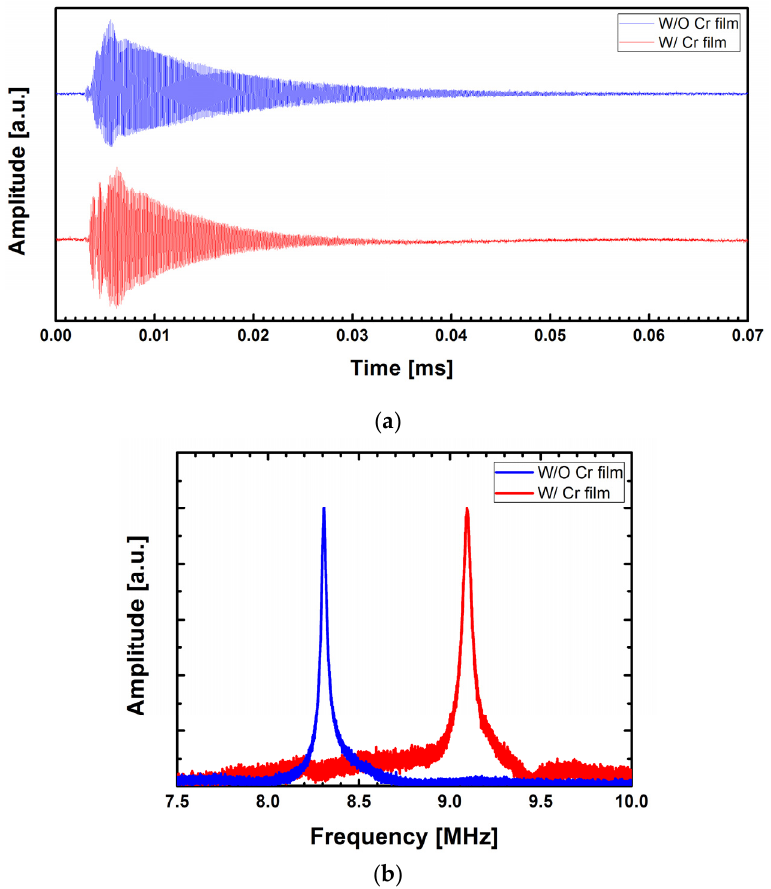
Figure 7. ( a ) Time-domain waveforms of the micromechanical resonators in the second flexural vibration mode; ( b ) frequency responses obtained from the fast Fourier transform (FFT) of the time-domain waveforms.